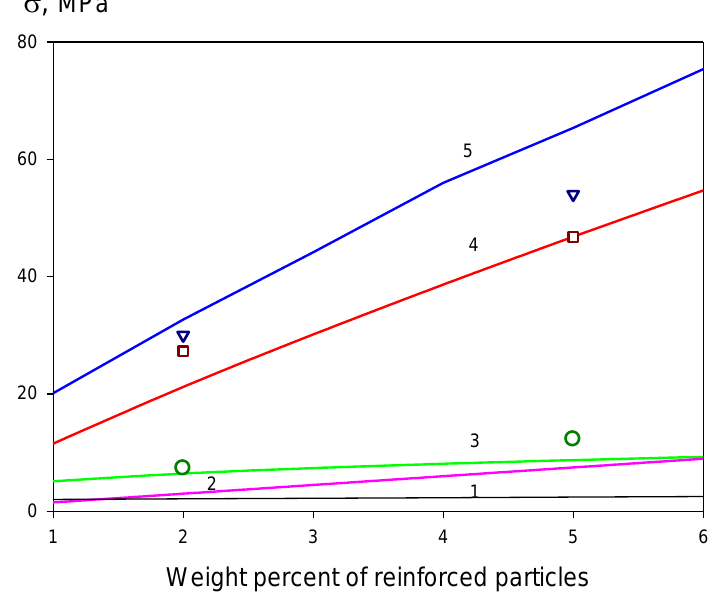
Figure 12. Dependence of different strengthening mechanisms on the mass fraction of the harden- ing particles: 1 — Hall – Petch stresses; 2 — Nardon and Prewo stresses; 3 — Orowan stresses; particles: 1—Hall–Petch stresses; 2—Nardon and Prewo stresses; 3—Orowan stresses; 4—thermal stresses; 5—strengthening stresses σ Str = σ NP + σ HP + σ Or + σ CTE ;